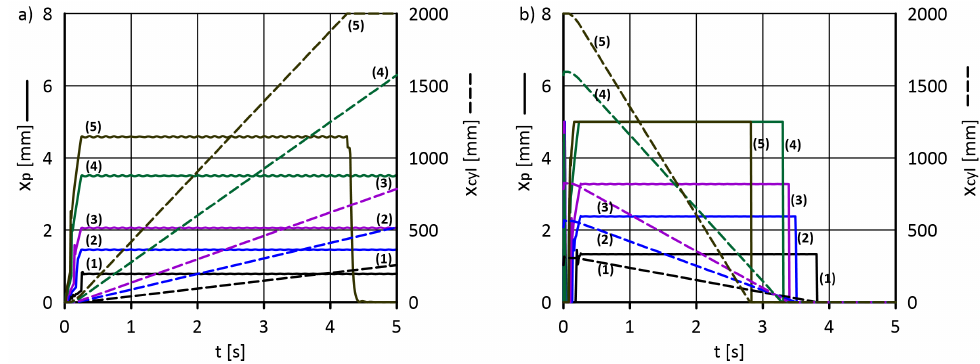
Figure 13. Check valve gap width x p ( t ) and hydraulic actuator displacement c cyl ( t ) for the increased stiffness k spr = k 2 = 57.4 N mm − 1 ; ( a ) A-B flow direction, ( b ) B-A flow direction.